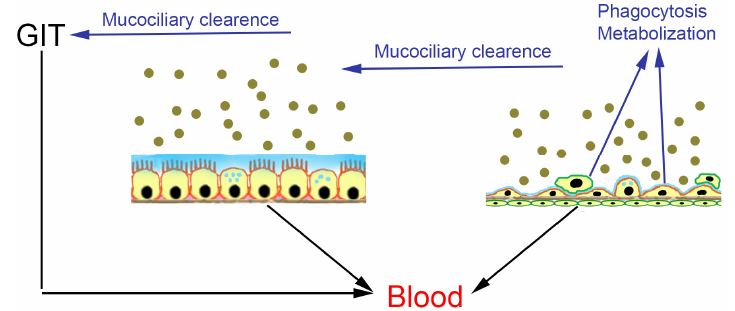
Figure 2. Fate of inhaled nanoparticles in conducting airways (bronchial epithelium) and alveoli. Particles can be either absorbed through the bronchial epithelium and enter systemic circulation or removed from the bronchial epithelium by mucociliary clearance (MC) and then absorbed in the gastrointestinal tract (GIT). Absorption pathway: black arrows; metabolization and excretion: blue